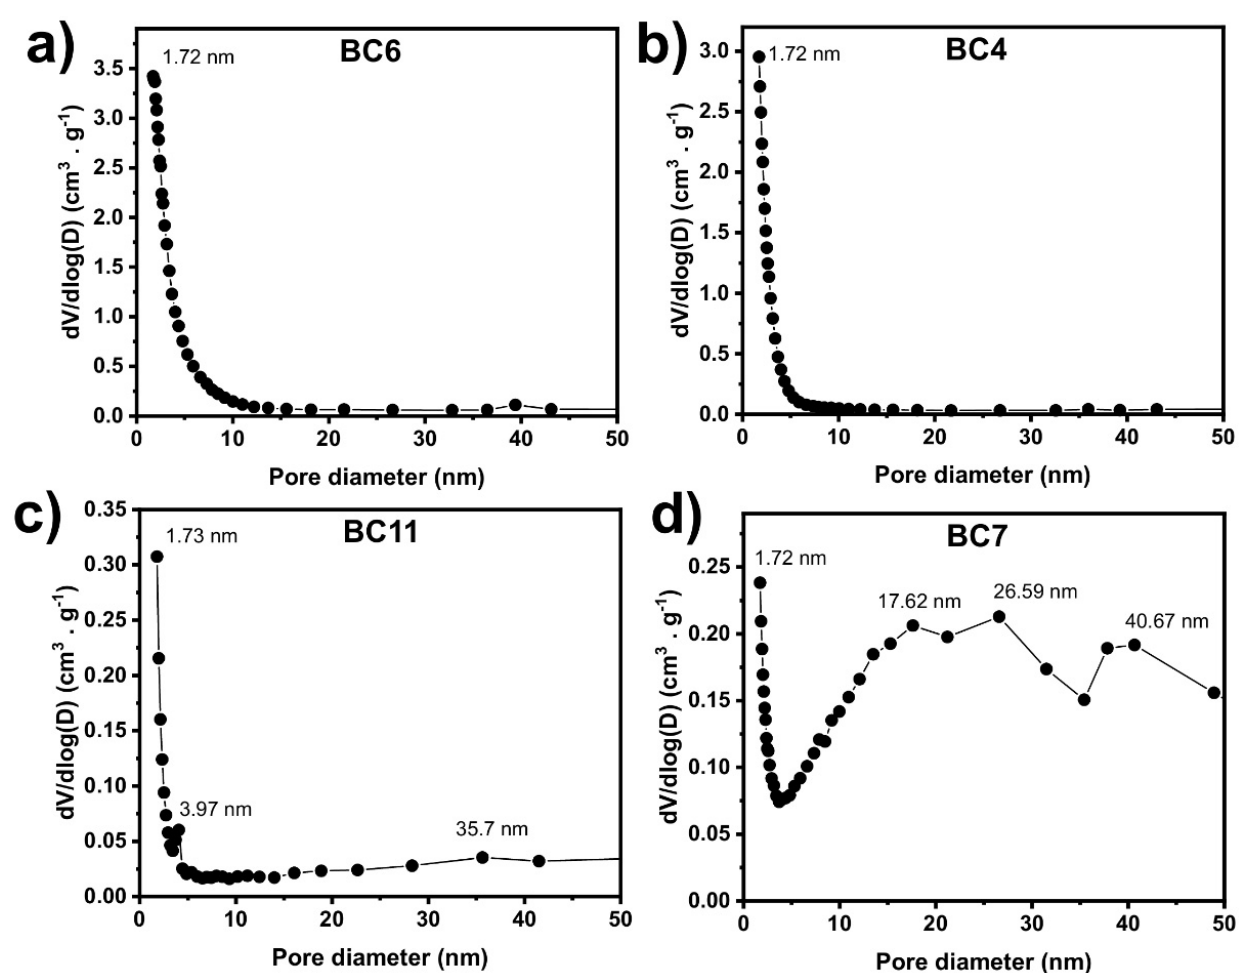
Figure 5. Pore size distribution of ( a ) BC6, ( b ) BC4, ( c ) BC11, and ( d ) BC7.